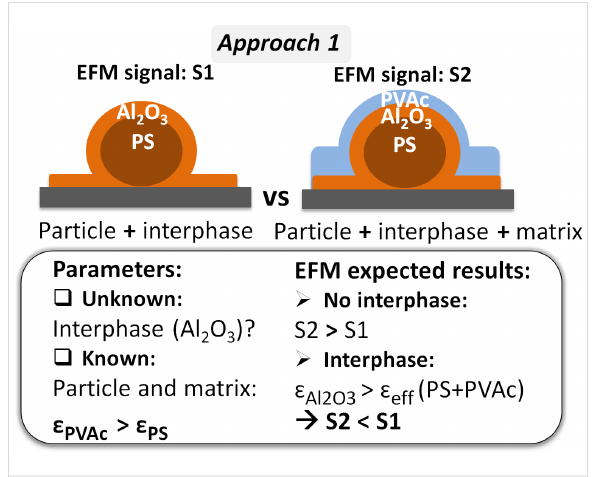
Figure 1: Interphase detection, approach 1: schematic representation of the samples to be compared, and methodology.